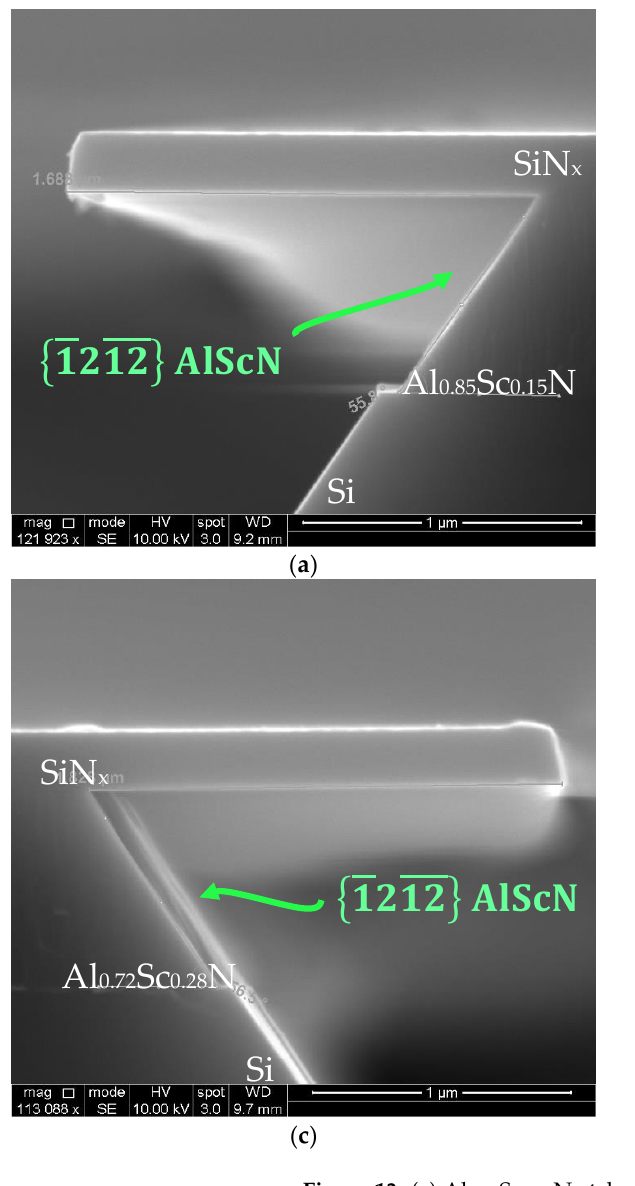
Figure 13. ( a ) Al 0.85 Sc 0.15 N etched for 20 min in 10 wt % KOH, etch front of AlScN approaching Si {111} ; ( b ) KOH preferentially etches Si {111} instead of {1212} AlScN; ( c ) Al 0.72 Sc 0.28 N etched for 20 min in 10 wt % KOH, etch front of AlScN aligned with Si { 111 } ; ( d ) KOH preferential etching of Si {111} instead of {1212} AlScN. All etches were performed at 60 °C.